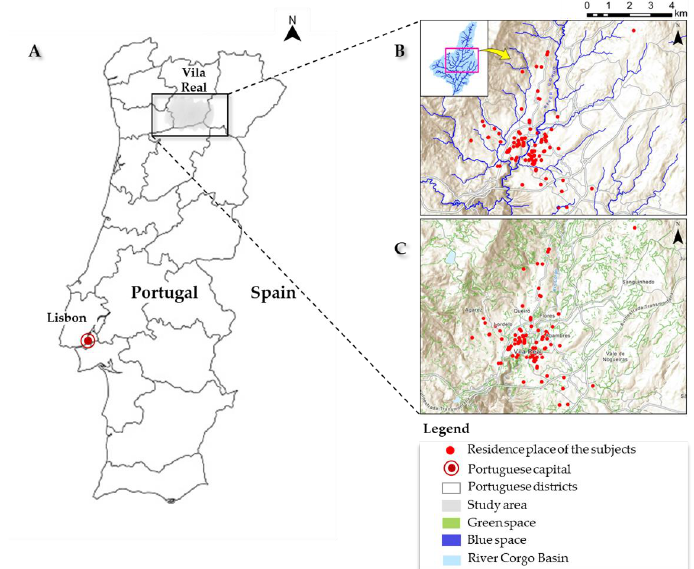
Figure 1. Location of the study area in Portugal ( A ), with blue ( B ) and green ( C ) areas.